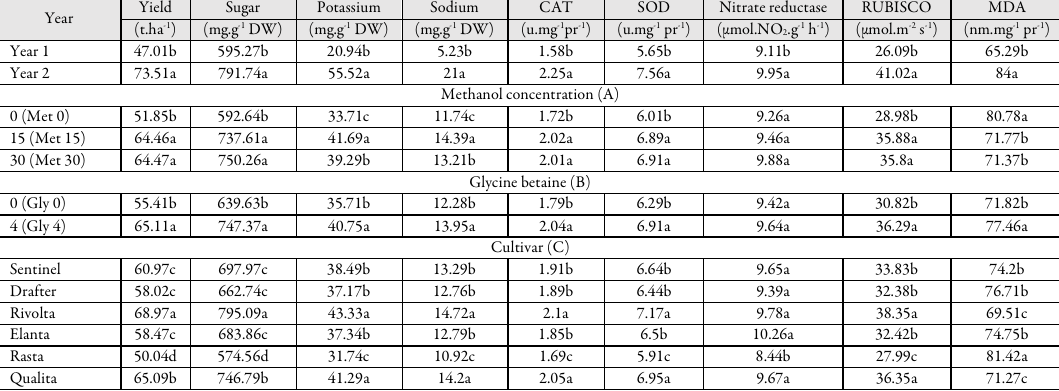
Table 4. Mean comparison of year, methanol and glycine betaine foliar application on yield, sugar, potassium, sodium, CAT, SOD, nitrate reductase, rubisco,